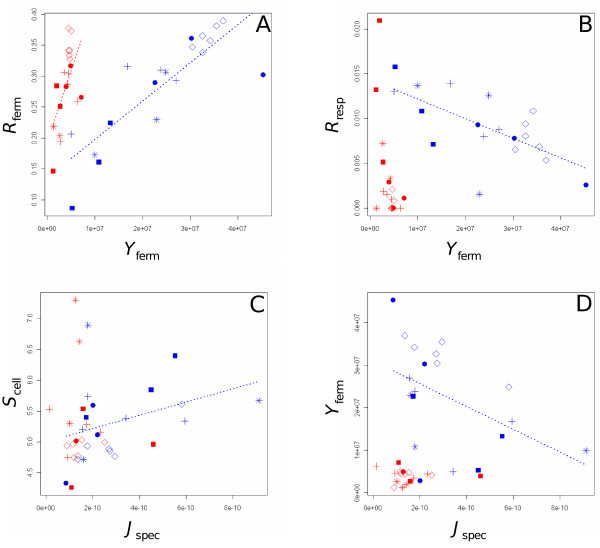
Relationships between life-history traits and metabolic traits. Each point corresponds to the mean value of traits for a strain in a glucose condition. Regressions were calculated in each glucose condition between (A) Rferm and Yferm, (B) Rresp and Yferm, (C) Scell and Jspec and (D) Yferm and Jspec. Same symbols as in Figure 2.